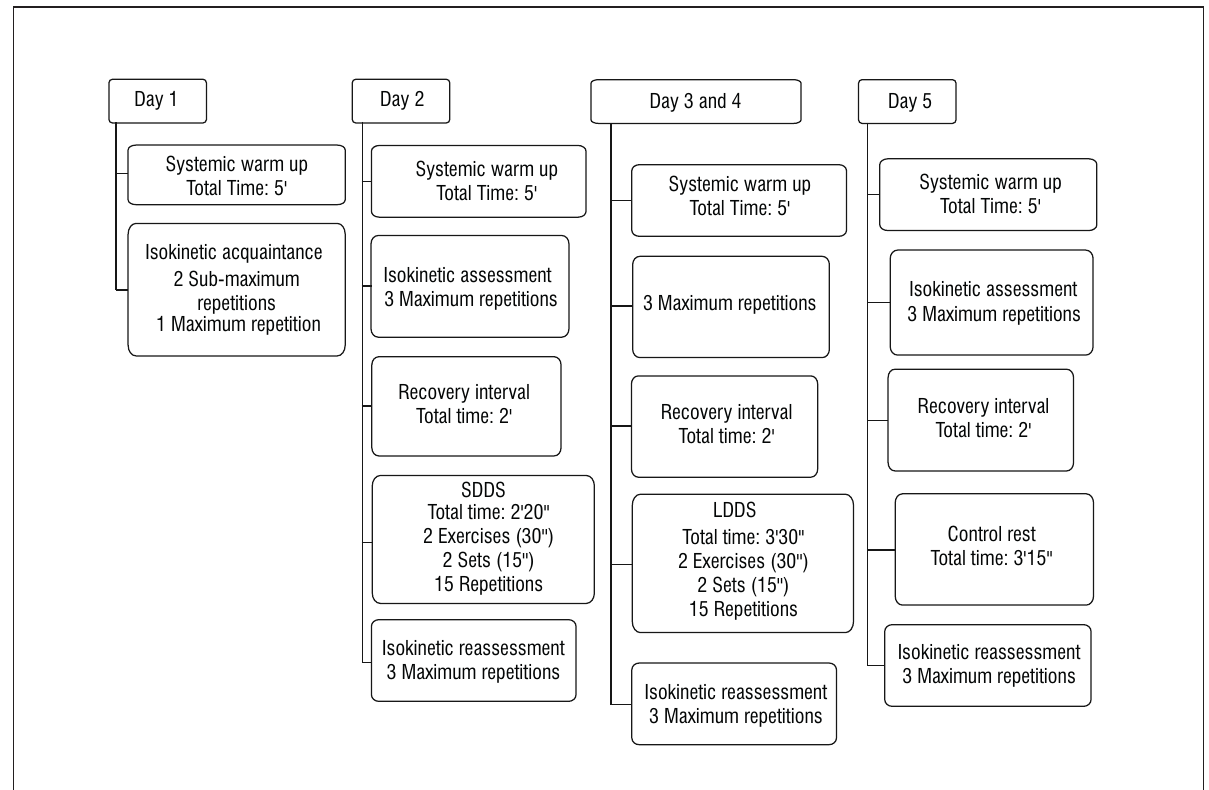
Figure 1 - Flowchart of the second phase of the study Source: Research